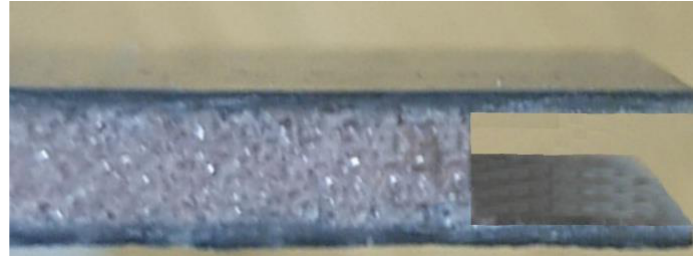
Figure 18. Modified end section of the sample for the tensile strength tests.